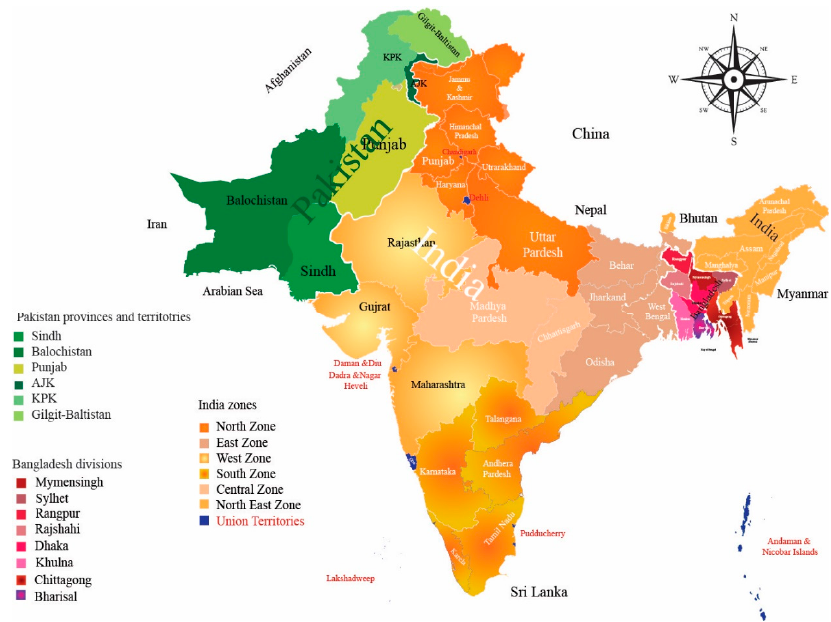
Figure 3. Map of IPB showing various provinces, territories, zones, and divisions.